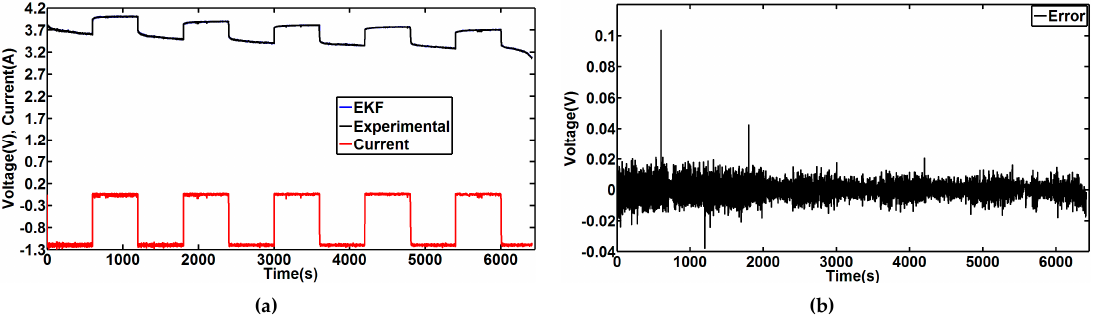
Figure 14. Experimental and EKF voltages for the 1.2 A current profile ( a ) voltages and current, ( b ) voltage error.